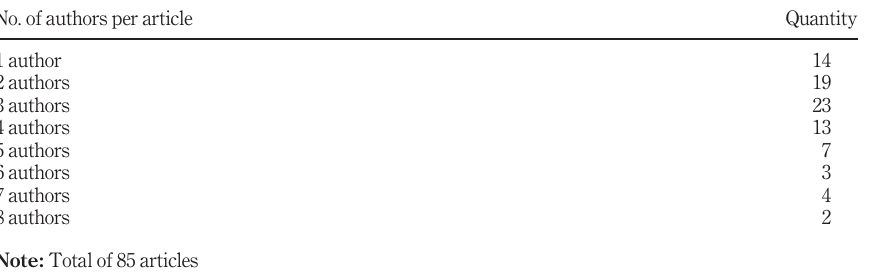
Table 2. Distribution